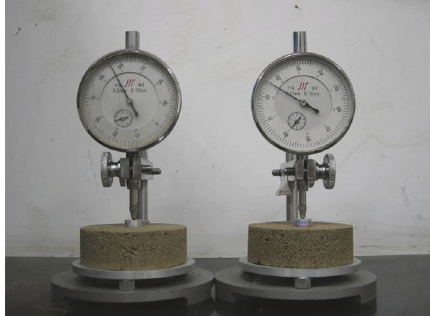
Figure 3: SS-1 contractometer used in shrinkage